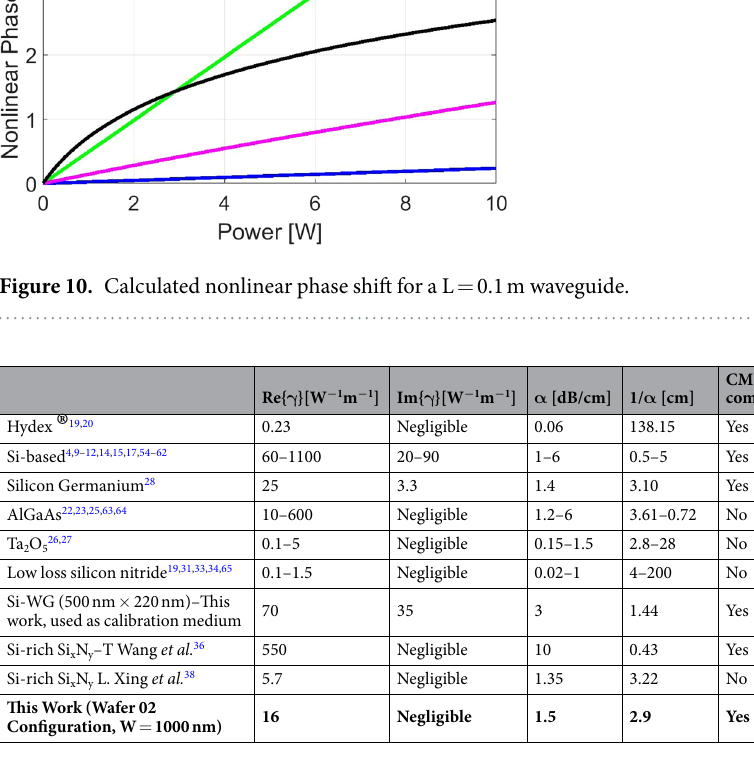
Table 4. Key parameters for different nonlinear waveguide